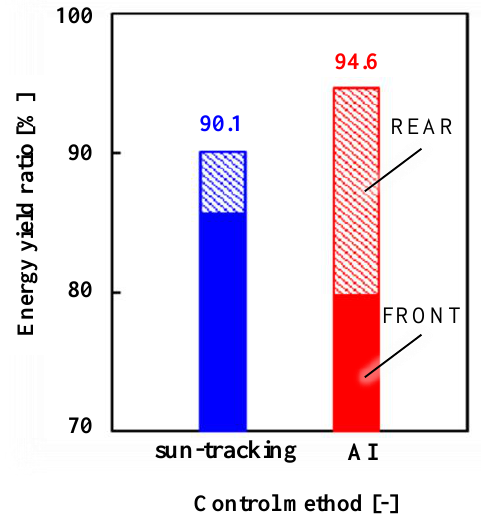
Figure 11. Variation of daily energy-yield ratio in the case of seasonal albedo changes (albedo = 0.8 from July 1 to August 31, albedo = 0.5 for the other months, RUN 1). Figure 12. Five-year energy-yield ratio average over RUNs 1–3 corresponding to Figure 11 (albedo = Figure 12. Five-year energy-yield ratio average over RUNs 1 – 3 corresponding to Figure 11 (albedo = 0.5).